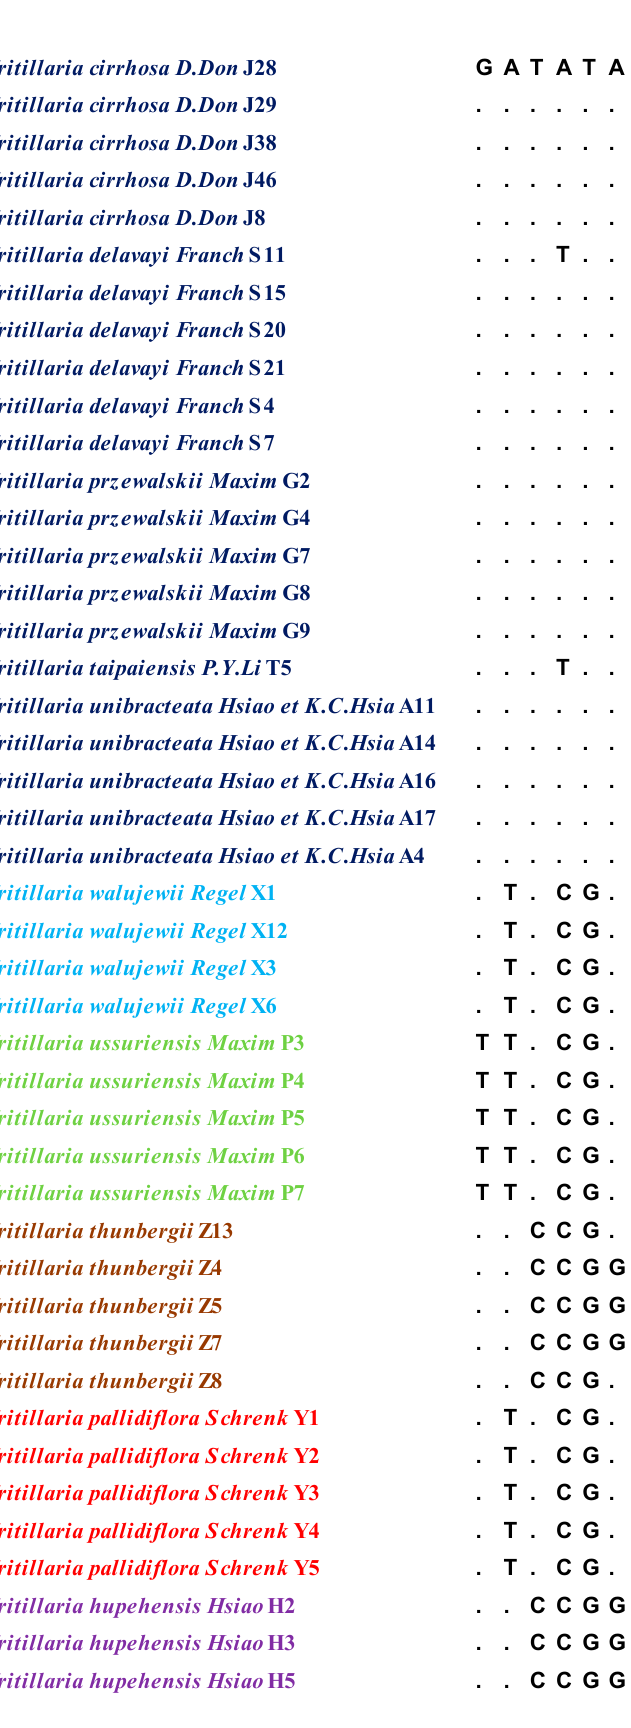
Figure 2. The intraspecific variable sites in the ITS2 sequences of Fritillariae Bulbus.